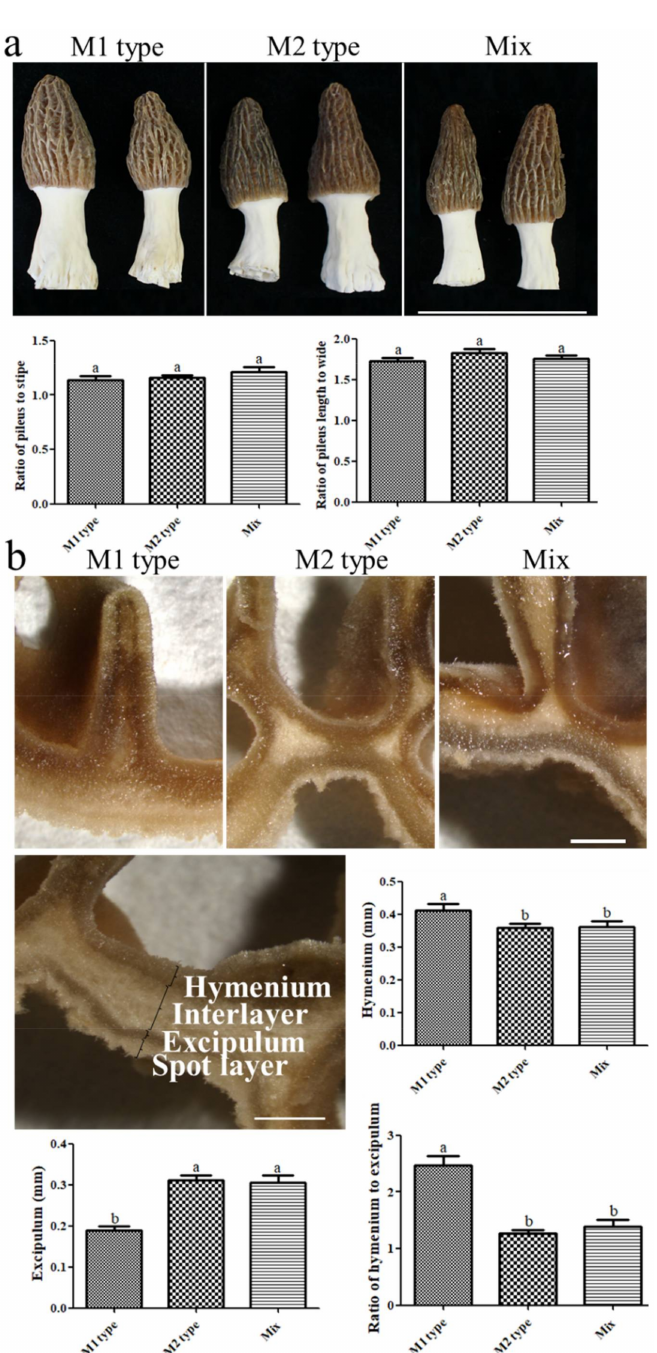
Figure 3. Appearance and structure of the fruiting body cultivated with strains of different types. ( a ) Appearance of different fruiting bodies, bar = 10 cm. ( b ) The structure division, shape and size of each layer of fruiting body, bar = 1 mm. Different letters above the bars indicate significant differences, one-way ANOVA, p < 0.05; the ANOVA results are shown in the supplementary files (Table